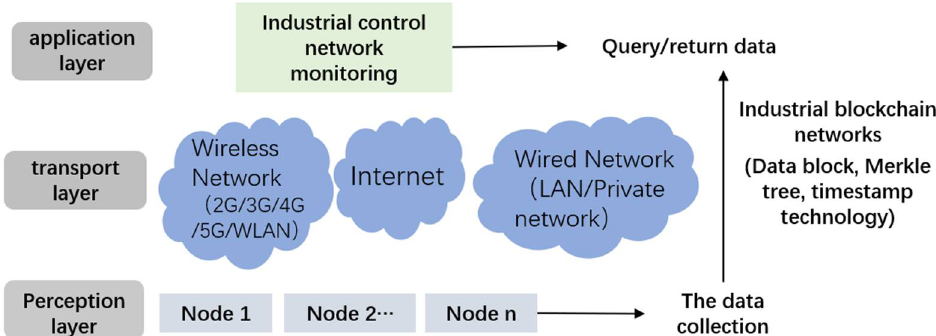
Figure 1. Industrial data security protection scheme.